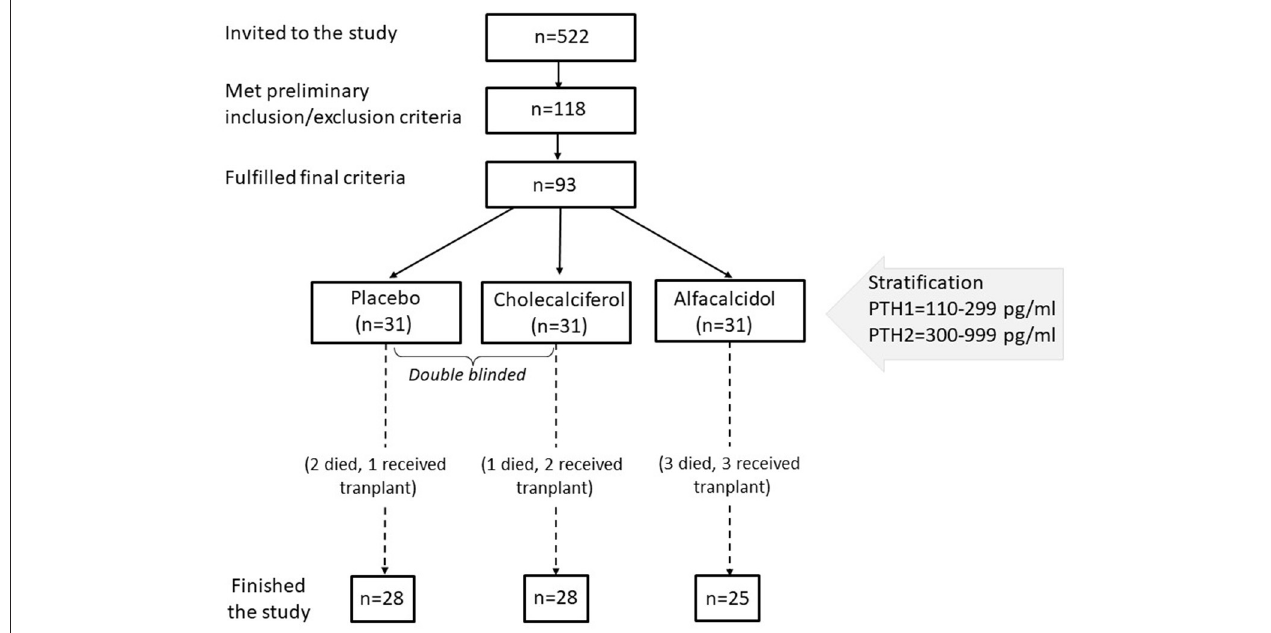
FIGURE 1 | The flow diagram of patients selection.